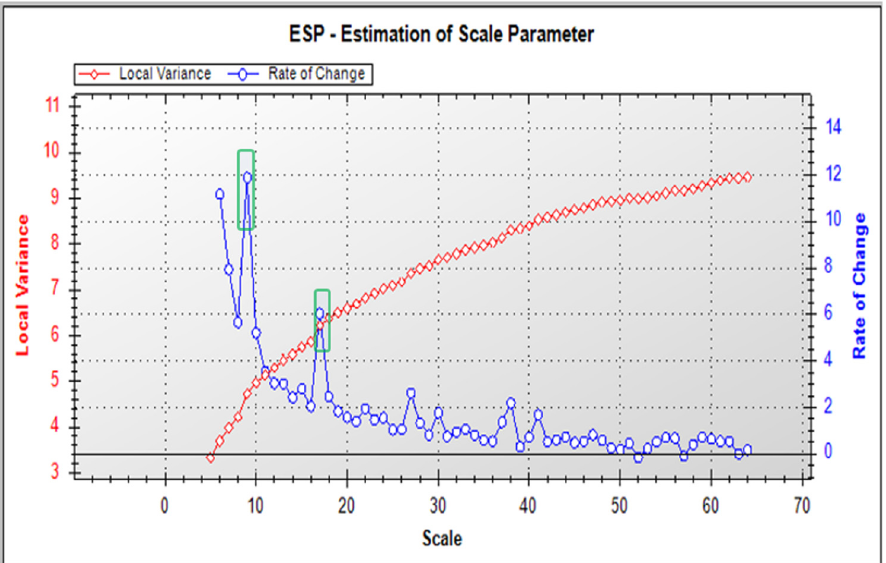
Figure 3. Illustration of the selection of an optimal scale parameter of multi-resolution segmentation based on Landsat imagery information. Graphs depict changes in local variance (LV) (red dots) and rate of change (blue dots) with increasing scale parameters. Vertical green boxes indicate optimal (critical) scale parameters selected for each scene.